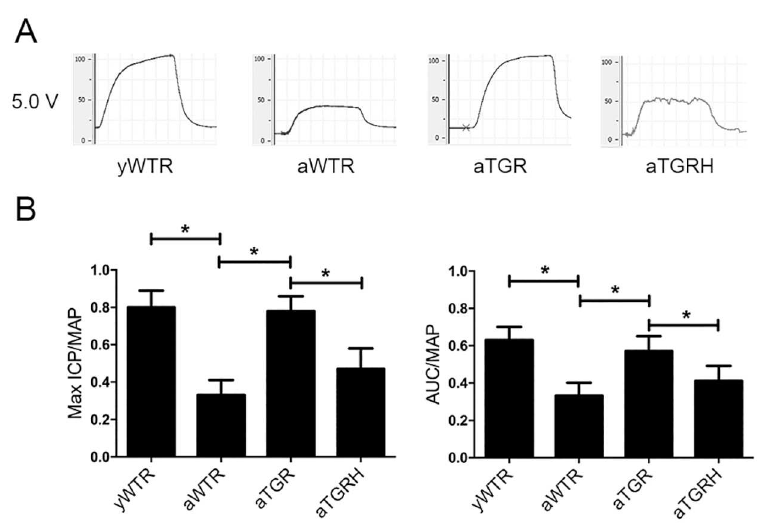
Fig 1. Erectile Function of all rats was measuredthrough cavernous nerve electrostimulation. (A) Representative curves of ICP through the electrostimulation of 5V setting for 1 min. (B) Erectile function was evaluatedby measuring the maximal ICP/MAP, and the AUC/MAP. The data are expressedas mean ± s.d. * P < 0.05when comparing the two groups under each end of the capped line. ICP: intracavernous pressure; MAP: mean arterial pressure; s.d.: